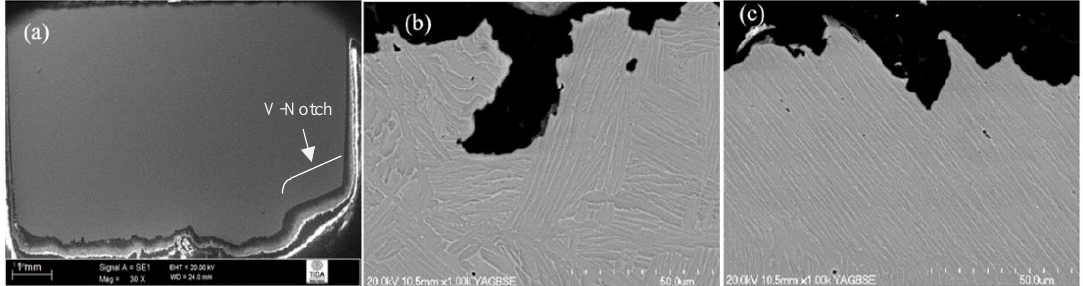
Figure 8. Crack propagation behaviour of as-extruded Ti-6Al-4V alloy: ( a ) overall crack path; ( b ) major deviation caused by colony interface; ( c ) limited resistance provided by retained β phase matrix.